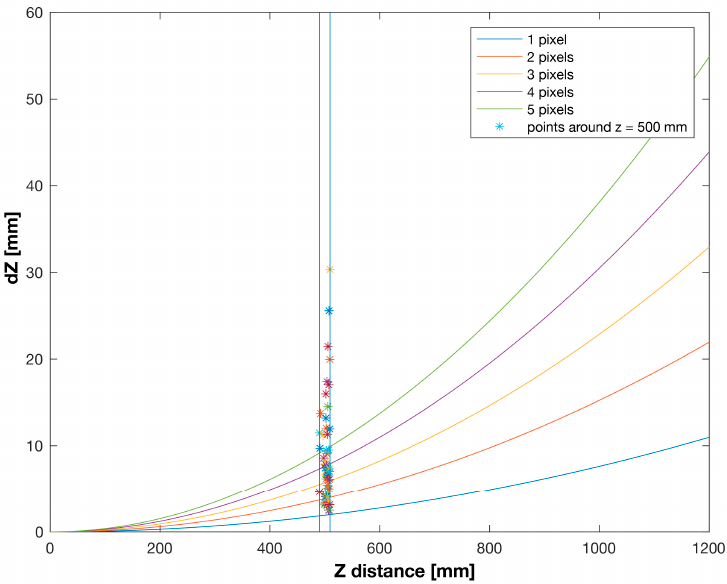
Figure 10. Depth resolution vs distance from the observer with different values of horizontal disparities. The asterisks are the values of (cid:102) dZ associated to the measured disparities around plane π .